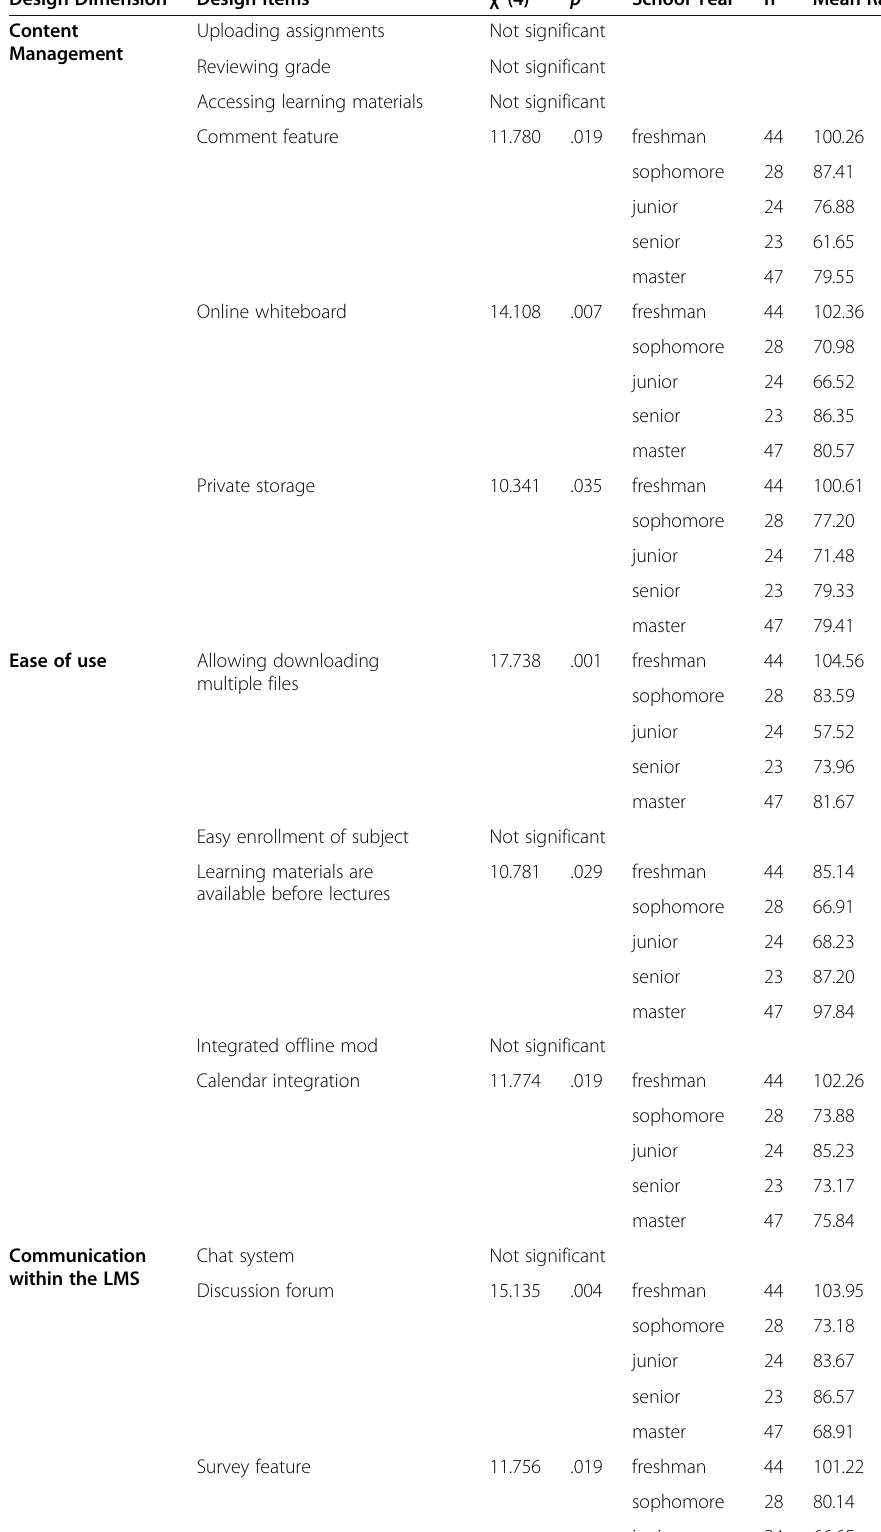
Table 6 The Kruskal Wallis H tests results for the school year variable Design